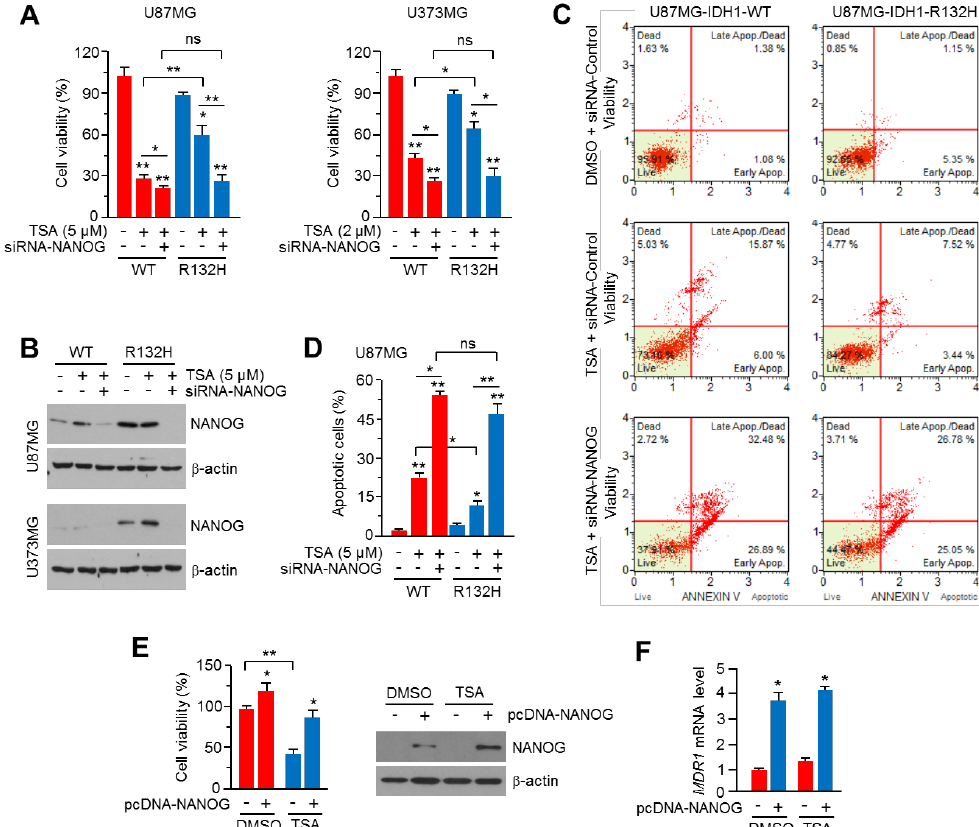
Figure 5. Suppression of NANOG abolishes TSA resistance in IDH1 R132H expressing U87MG and U373MG glioblastoma cells. ( A ) IDH1-WT or IDH1 R132H expressing U87MG or U373MG cells were transiently transfected with 20 nM of siRNA against control or NANOG. Transfected cells were incubated for 24 h to allow stabilization and further incubated with or without TSA for 48 h, as indicated. Cell viability was analyzed by using crystal violet staining. The values represent the mean ± SD of three independent experiments performed in duplicate; * p < 0.05 and ** p < 0.01. ( B ) Protein levels were measured by using western blotting. ( C , D ) IDH1-WT or IDH1 R132H expressing U87MG cells were transiently transfected with 20 nM of siRNA against control or NANOG. Transfected cells were incubated for 24 h to allow stabilization. After stabilization, cells were further incubated with or without TSA (5 µ M) for 72 h. Apoptotic cell population was measured by using Annexin-V staining and Mini Flow Cytometry Muse ™ Cell Analyzer. The values are presented as the mean ± SD of three independent experiments performed in duplicate; * p < 0.05 and ** p < 0.01. ( E ) U87MG cells were transiently transfected with pcDNA3.1-NANOG, and incubated for 24 h to allow stabilization. Transfected cells were incubated with or without 5 µ M of TSA for 48 h. Cell viability was analyzed by using crystal violet staining and NANOG expression was measured by using western blotting. The values represent the mean ± SD of two independent experiments performed in triplicate; * p < 0.05 and ** p < 0.01. ( F ) MDR1 mRNA levels were measured by using qRT-PCR. The values represent the mean ± SD of three independent experiments performed in duplicate; * p < 0.05.